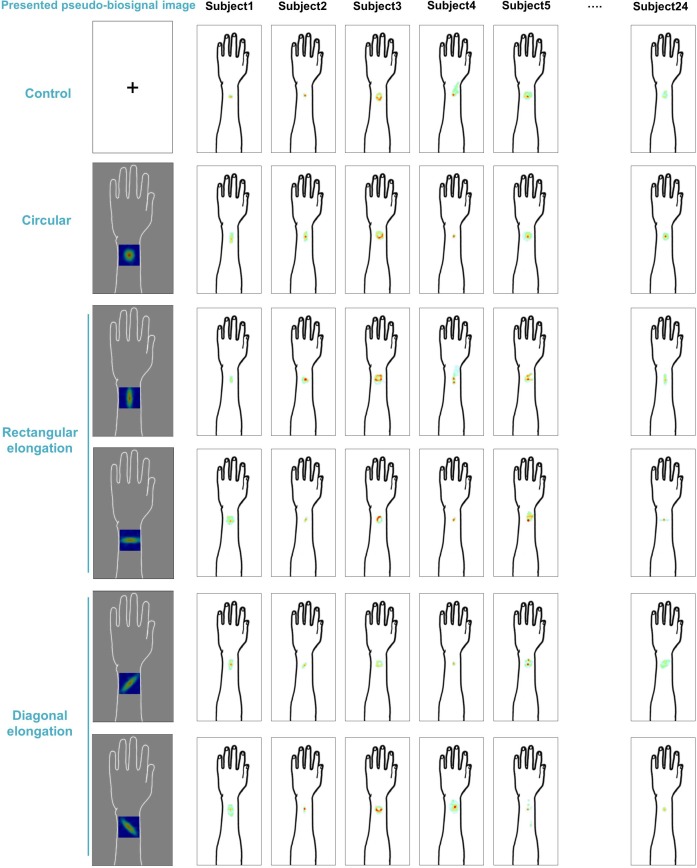
Individual map for somatic sensation spatial patterns following tactile stimulation in each condition. Six examples of individual de qi sensation drawings.